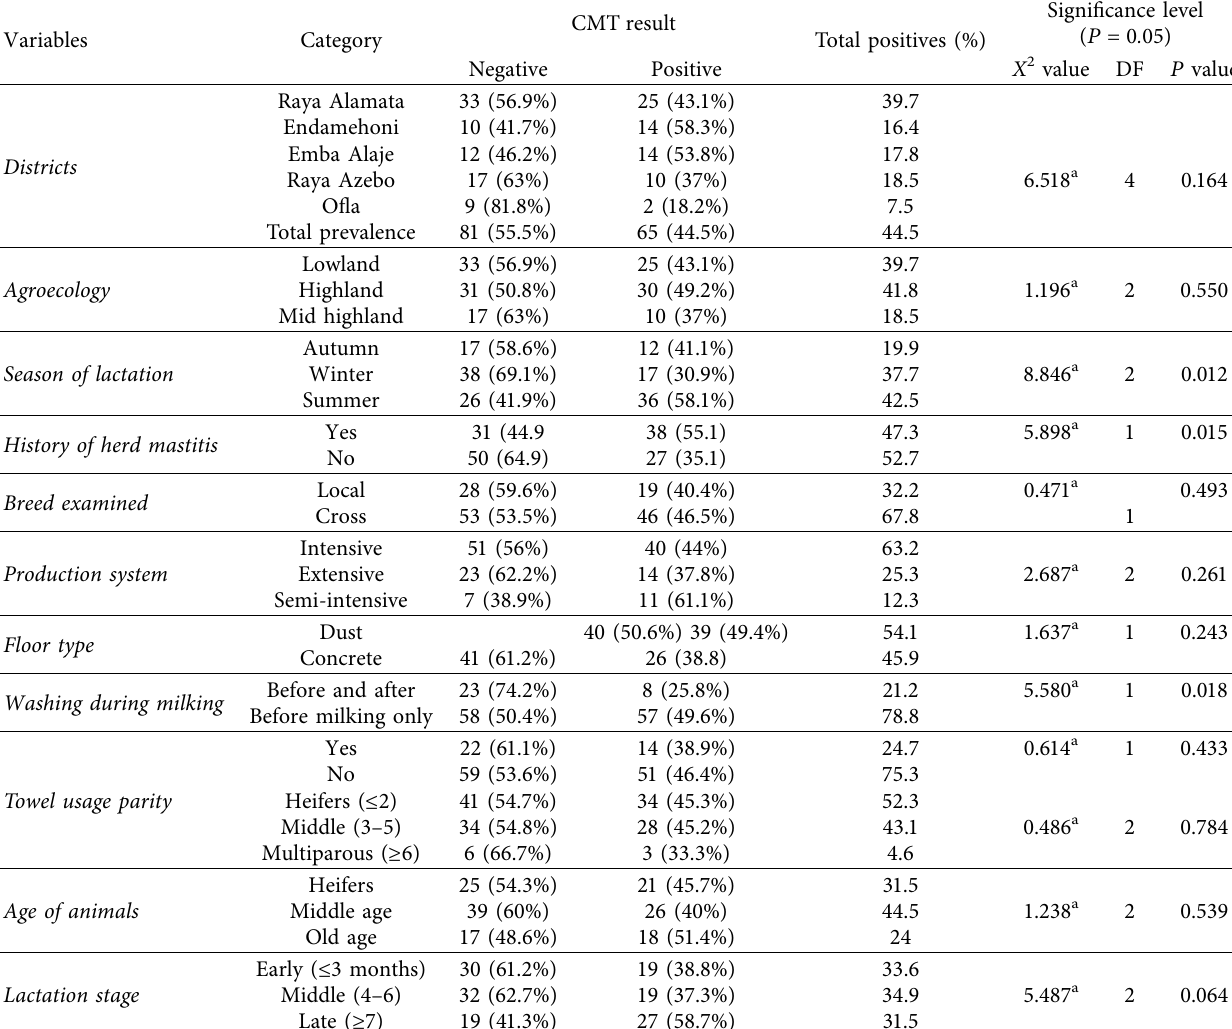
Table 1: Proportion of associative risk factors and level of significance.